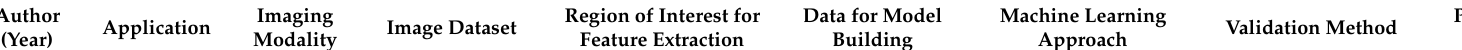
Table 2. Performance of radiomics models on CT/CBCT images for maxillofacial